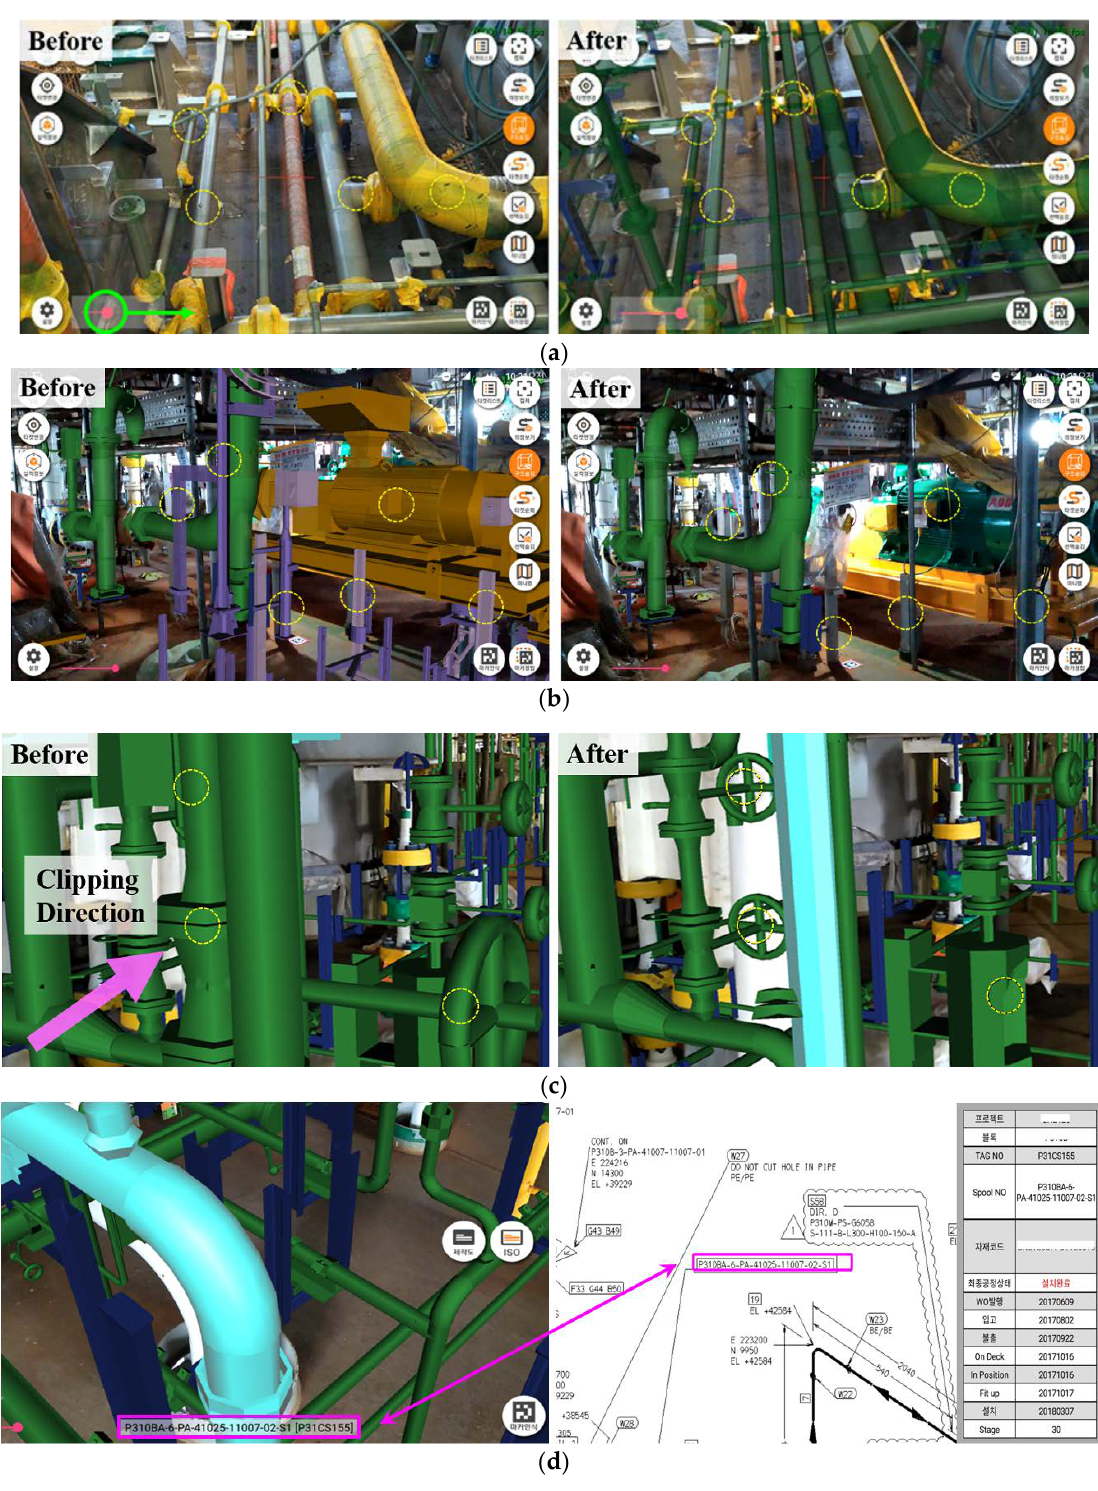
Figure 16. Functions for fabrication and inspection support using AR technology. ( a ) transparency control; ( b ) discipline filtering; ( c ) view clipping; ( d ) drawing linkage.